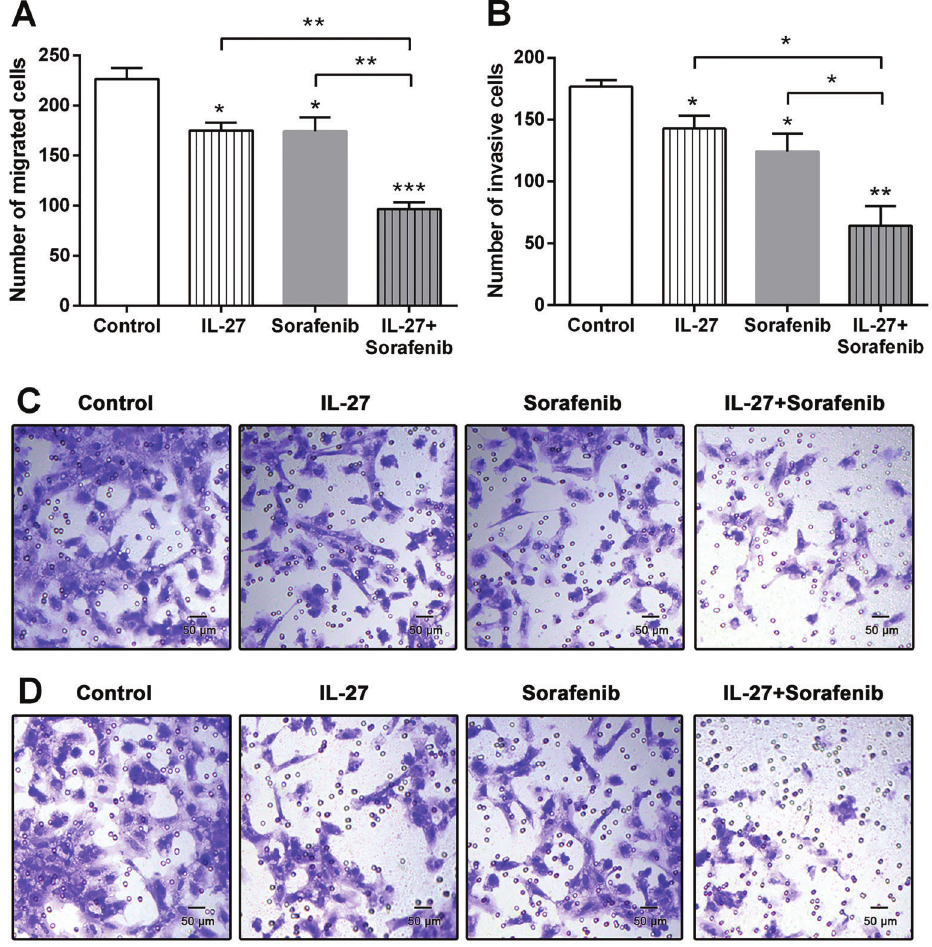
Figure 3. Effect of IL-27 (50 ng/mL) and sorafenib (2 m M) alone or combination on HTB-9 cell migration ( A ) and invasion ( B ), assessed by modi fi ed Boyden chamber. Cells cultured with blank medium acted as control. C , Representative photos of the cell migration assay, and D , the cell invasion assay. Data are reported as the mean ± SE of 3 independent experiments. *P o 0.05; **P o 0.01; ***P o 0.001 compared to control unless indicated otherwise ( t -test). IL-27: interleukin